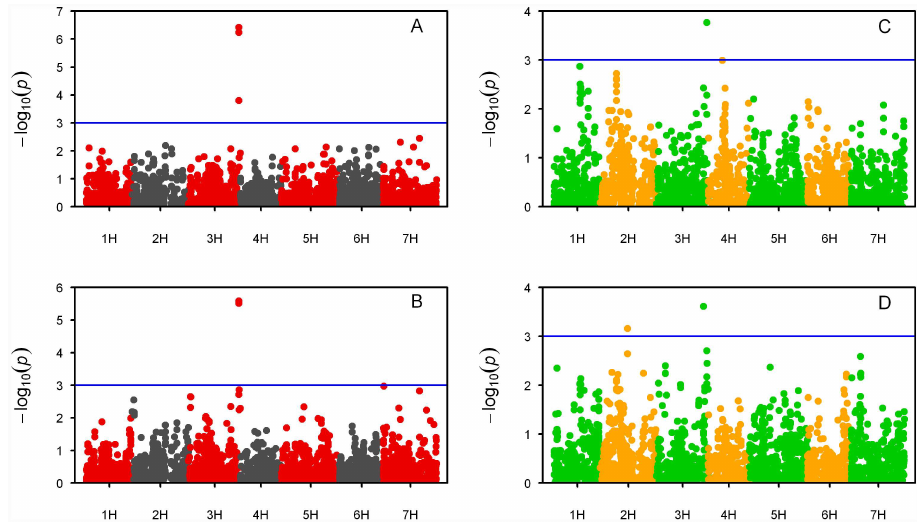
Fig 3. Manhattan plots from GWAS results. GWA scan results for A) GYLD 2009; B) GYLD 2010; C) LM6 2009; D) LM6 2010. The blue horizontal line in each plot representsthe arbitrary significantthresholdat -log10 (p value) =